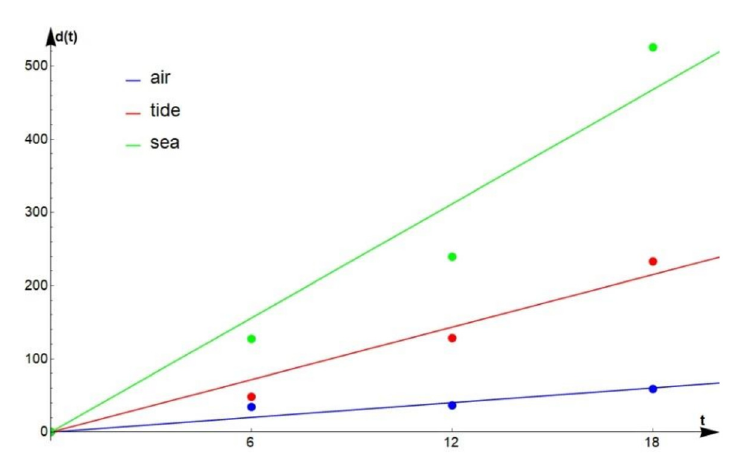
Figure 7. Linear model for the NiTi-1 alloy.